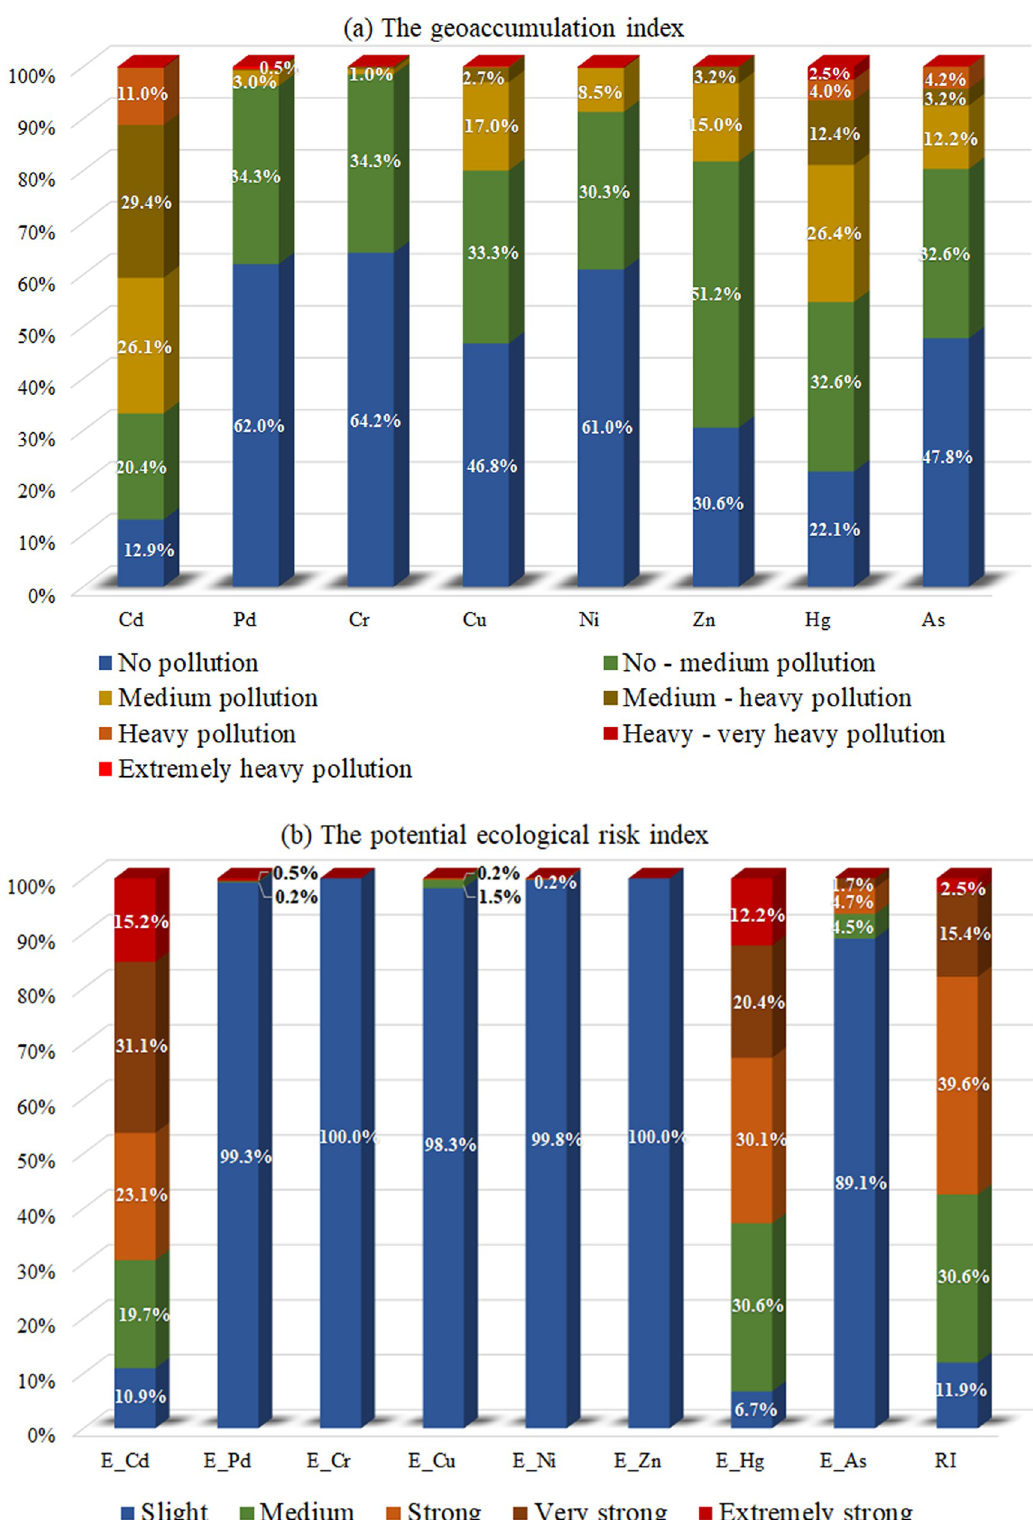
Fig 3. Composition of pollution level assessed due to calculated results of (a) geo-accumulation index and (b) potential ecological risk.